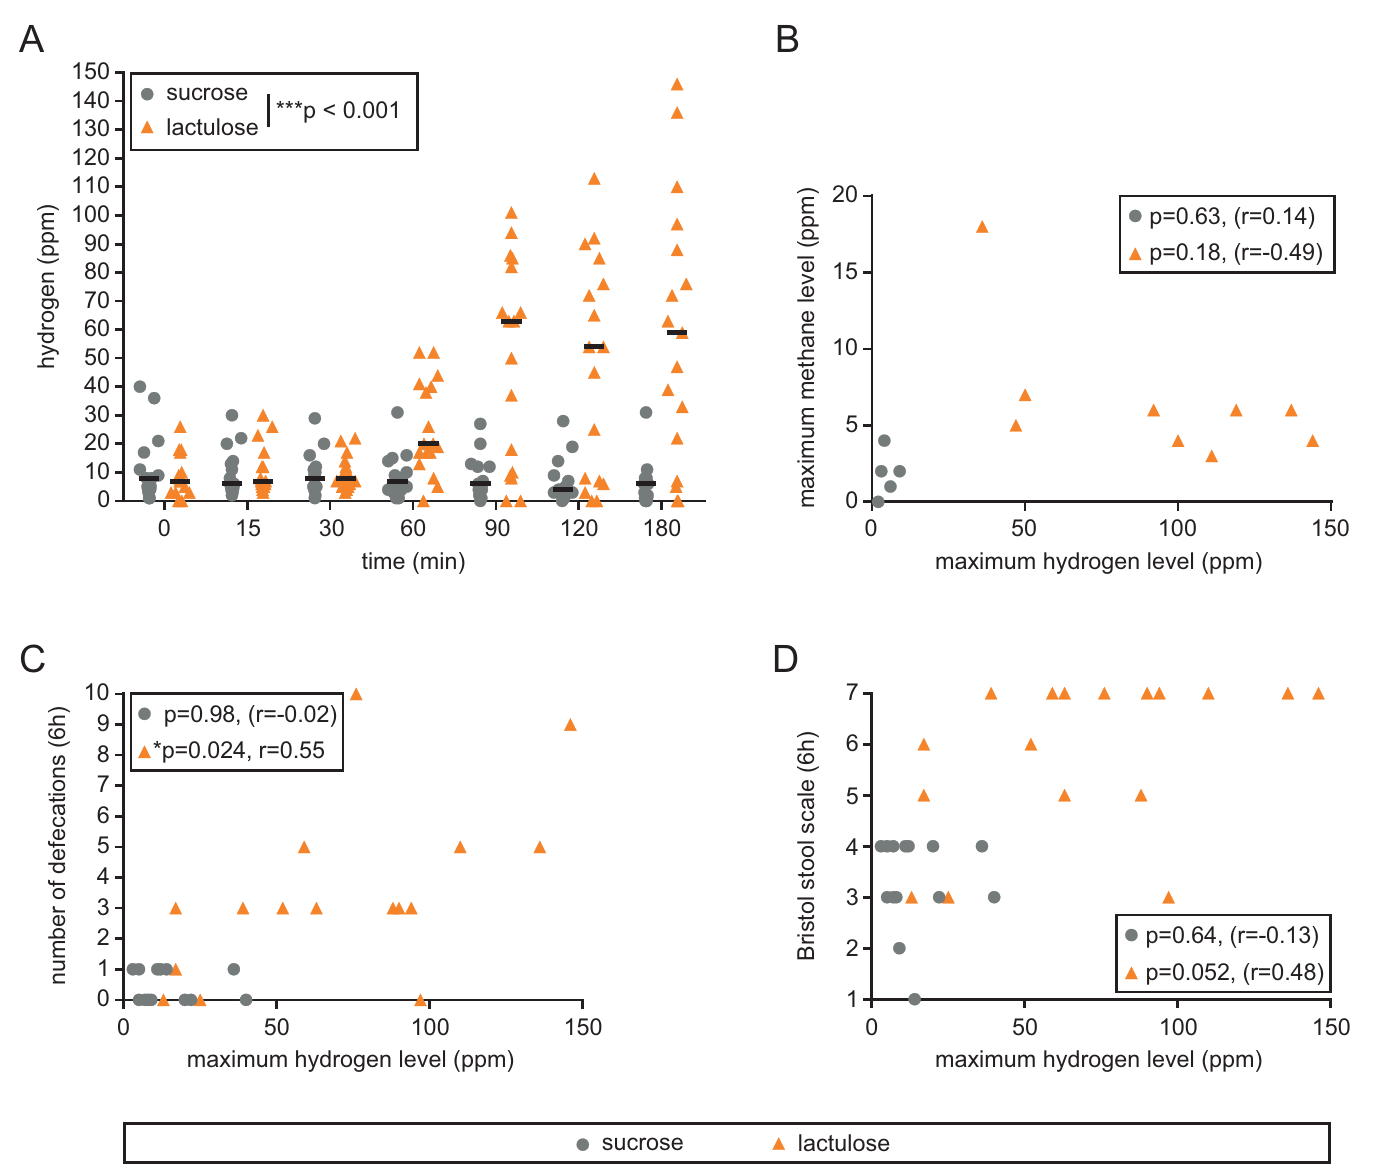
Fig 4. Hydrogen and methane levels and symptoms following lactulose ingestion. (A) Hydrogen levels in parts per million (ppm) following lactulose or sucrose (control) ingestion. ��� p < 0.001; two-way repeated measures ANOVA. (B) Correlation between maximum (max) hydrogen and methane levels. (C) Correlation between maximum hydrogen levels and number of defecations during 6 hours following lactulose or sucrose ingestion. (D) Correlation between maximum hydrogen levels (max) and stool consistency (Bristol stool scale) following lactulose or sucrose ingestion. r: Spearman R correlation coefficient.